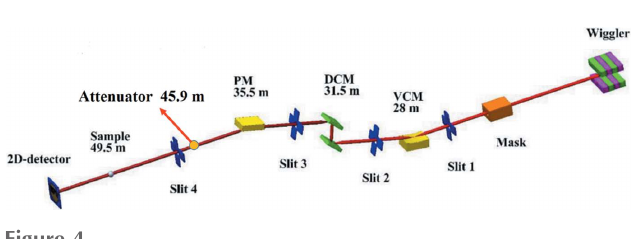
Figure 4 PXM in DCM mode.